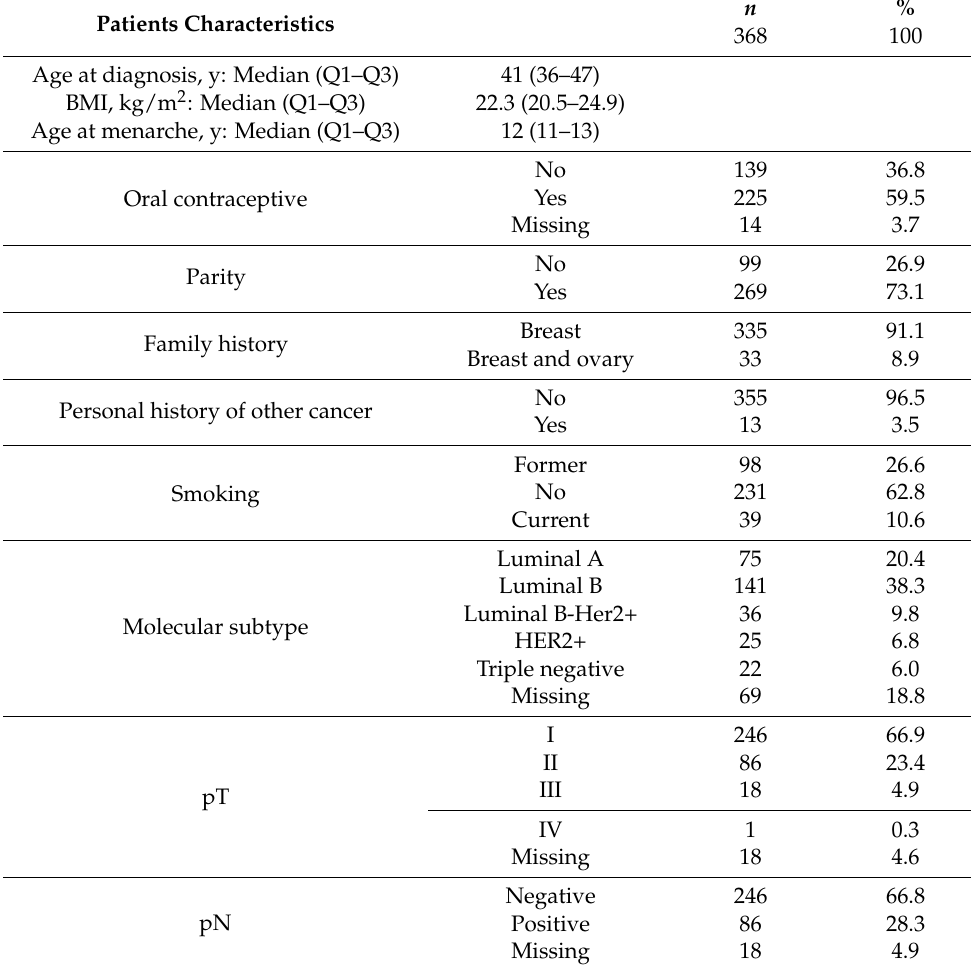
Table 1. Baseline patients and tumor characteristics of breast cancer women wild type for BRCA1/2. Patients